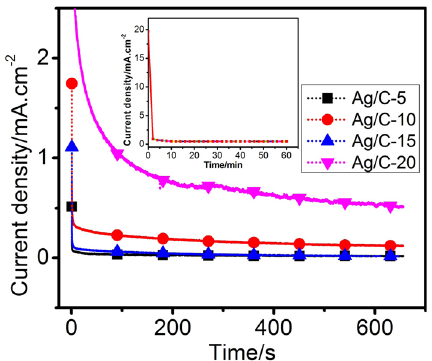
Fig. 9 CA curves of all Ag/C catalysts in 0.5 M NaOH + 0.01 M NaBH solution at 0.2 V. Inset shows the chronoamperometry profile of Ag/C-20 up to 1